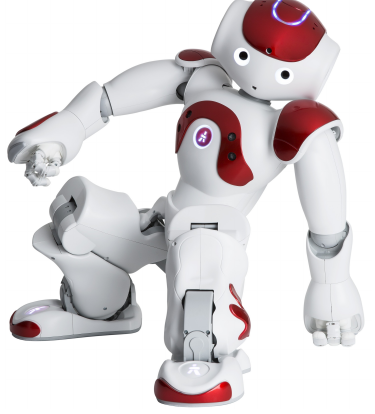
Figure 3. Nao robot